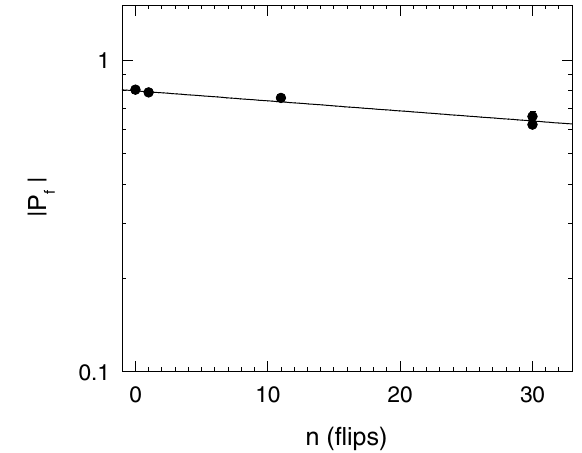
FIG. 5. The measured proton polarization at 1 : 941 GeV =c is plotted against the number of spin flips. The rf-dipole’s fre- quency ramp time (cid:15) t was 10 s; its frequency half range (cid:15) f= 2 dl was 0.11 T mm. The line is a fit was 4 kHz, and its R B rms using Eq.